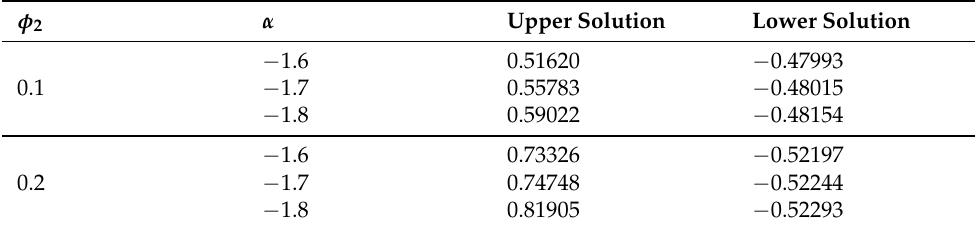
Table 5. Smallest eigenvalue numbers of γ against φ 1